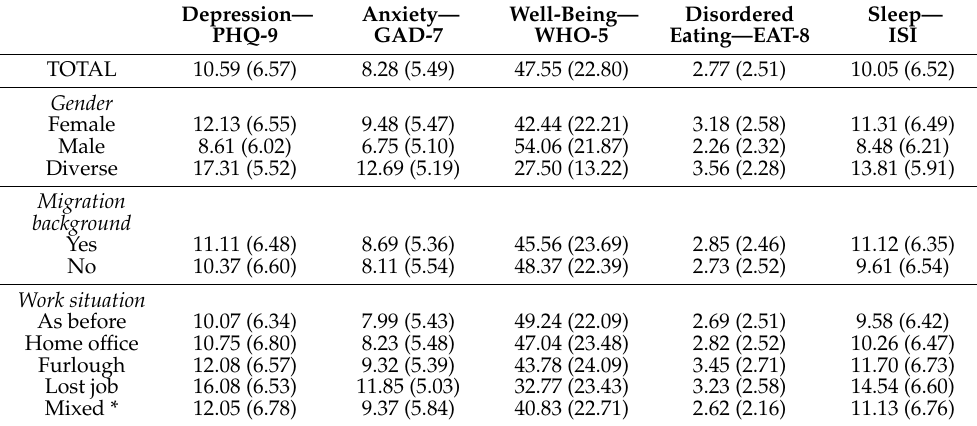
Table 2. Means and standard deviations of each mental health measure for the total sample and according to gender, migration background, and work situation.